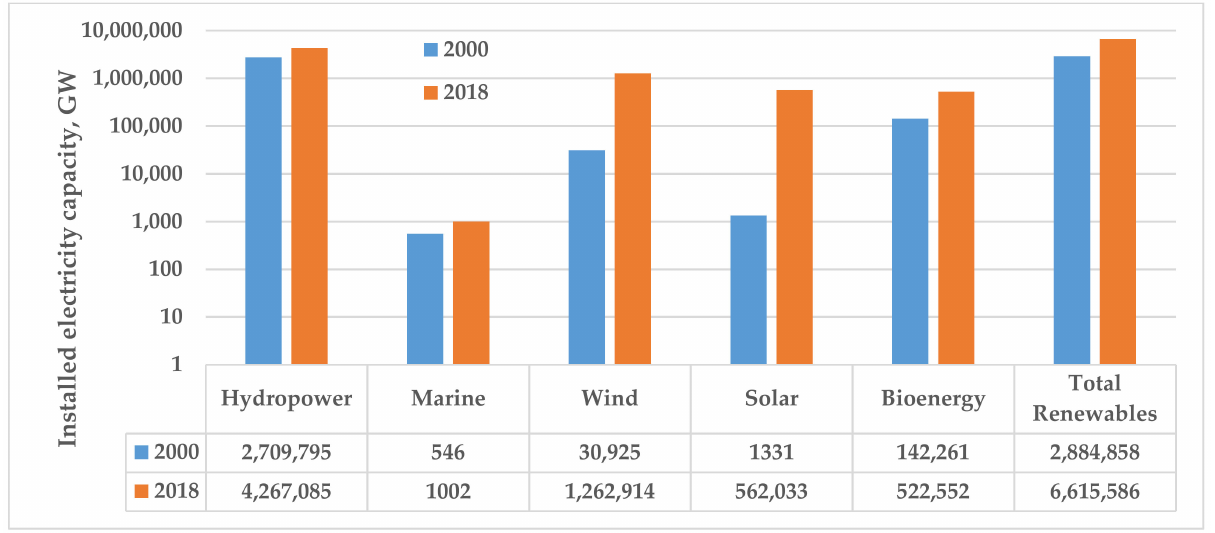
Figure 2. Installed electricity capacity of different renewable energy resources in 2000 and 2018 (data from [35]).